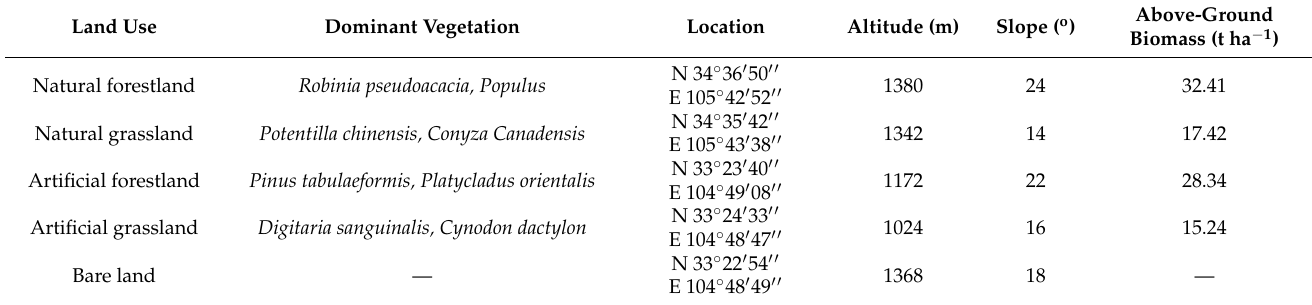
Table 1. Description of sampling